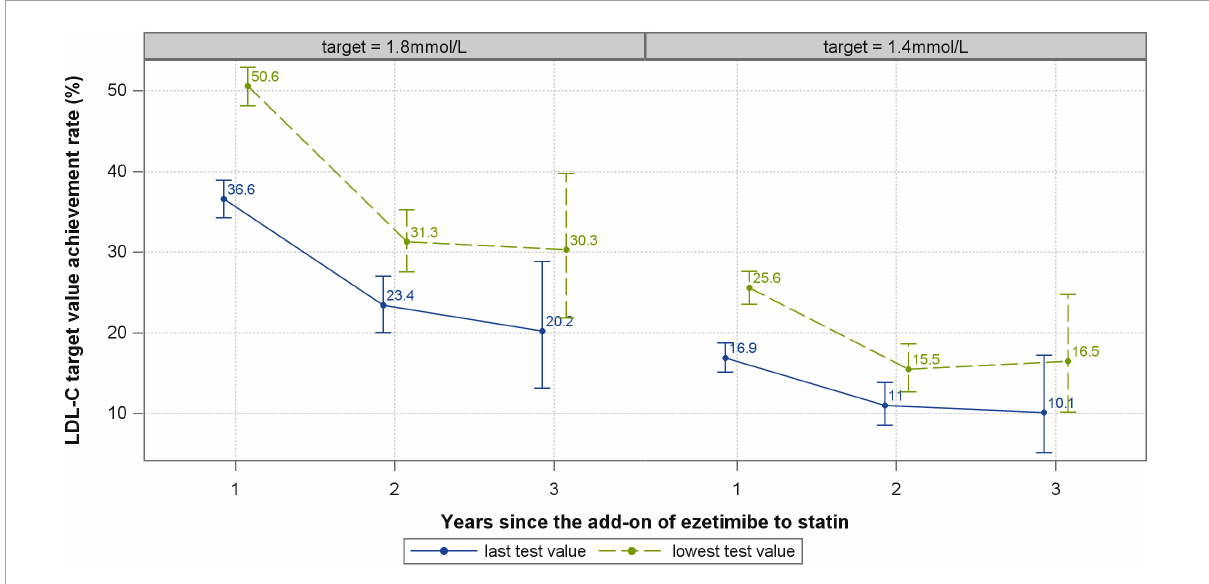
FIGURE3 LDL-C target value achievement rate first 3 years after ezetimibe plus statin. The vertical lines and whiskers indicate the 95% confidence intervals of the relevant rates.